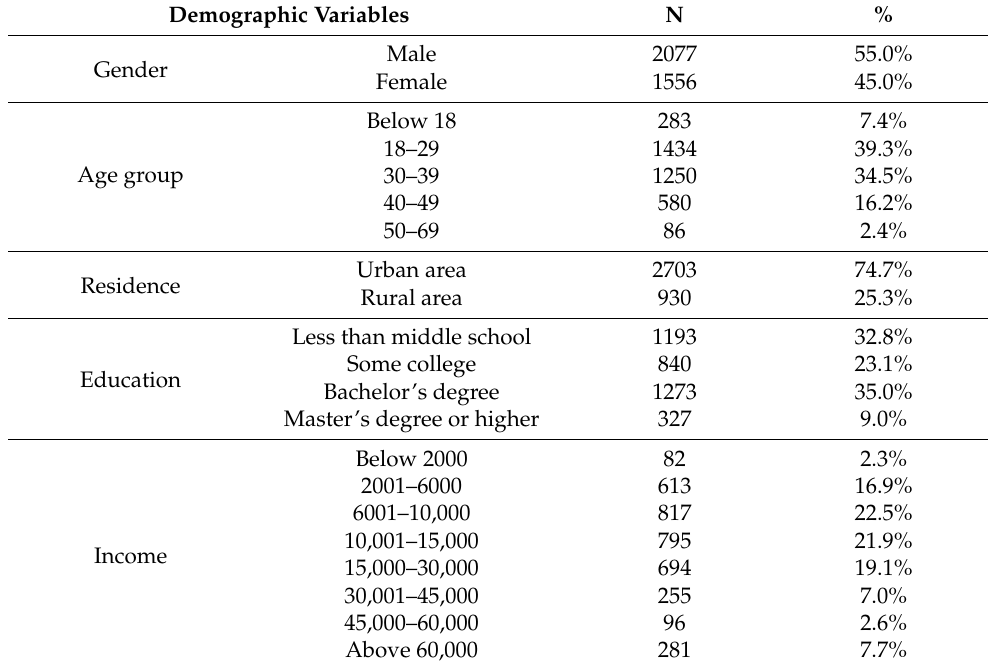
Table 1. Sample characteristics (N =